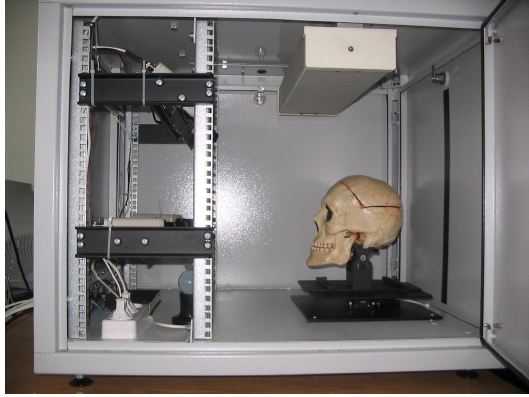
Figure 2. Automated digital photogrammetric system